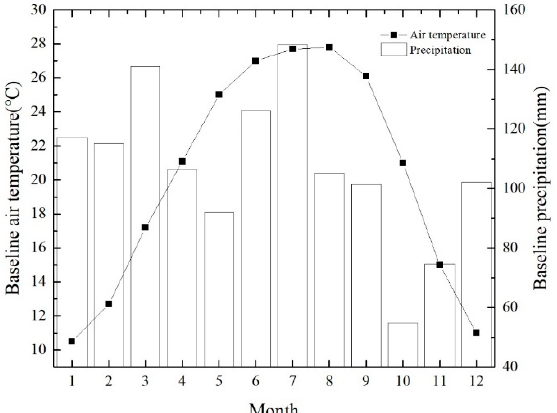
Figure A1. Long-term air temperature and precipitation baseline for the three EC flux sites from 1939 to 2000. The baseline annual average air temperature and cumulative precipitation for the three study EC sites were 20.17 °C and 1283.82 mm [47].